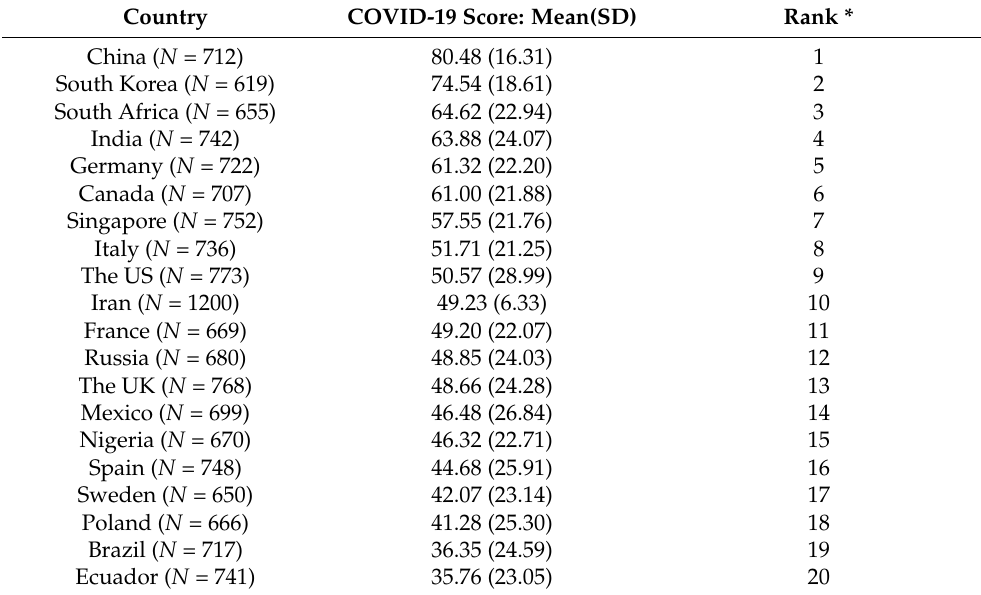
Table 4. Individuals’ Attitudes toward the Performance of Governments in the World and Iran Based on the Global Standard Index.